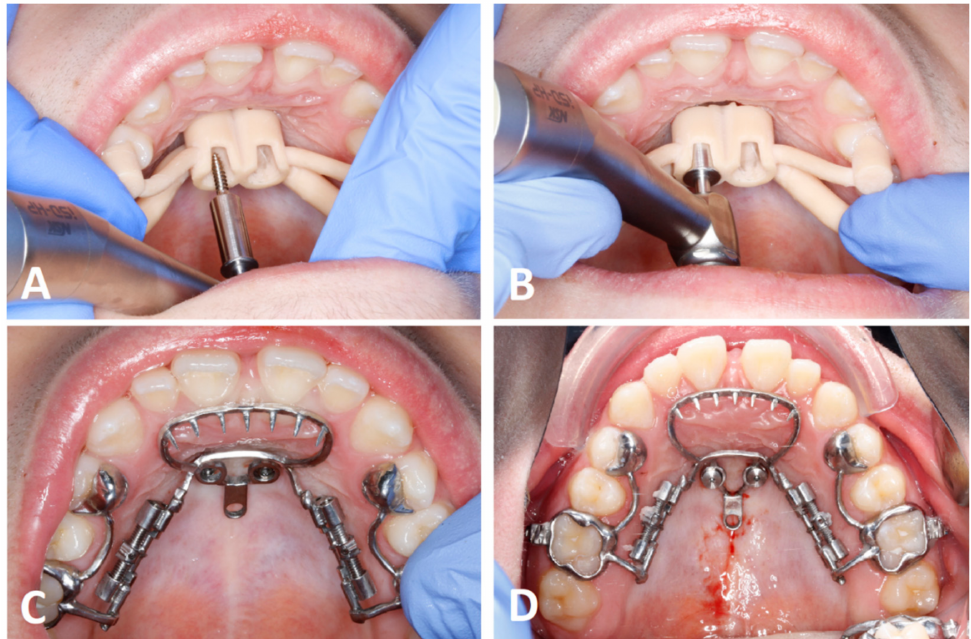
Figure 7. Appliance installation with guide: ( A ) Guided implantation. ( B ) Vertical control is achieved through a stop between the guide and the insertion tool. ( C ) Try-in on implants. ( D ) Appliance fastened on two implants by fixation screws.